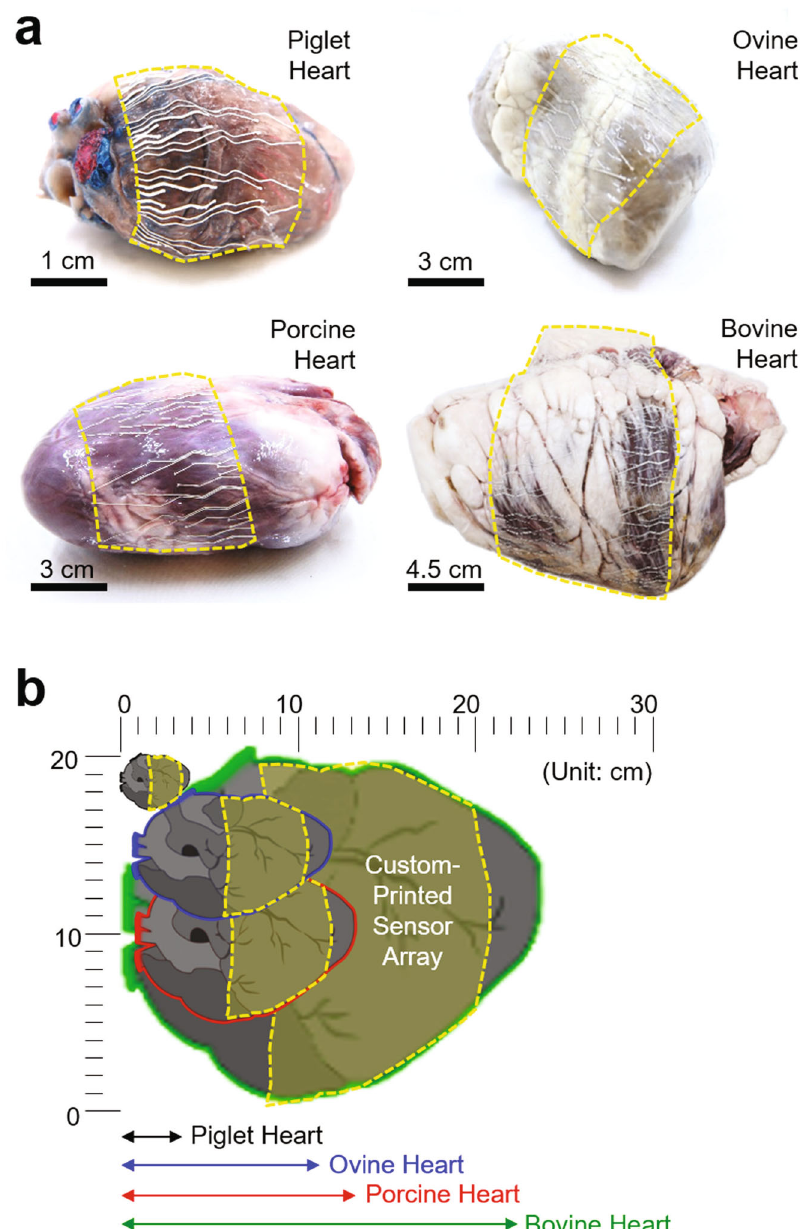
Fig. 3 Rapid custom prototyping. a Photographs of the custom-printed sensor arrays, each of which was customized to fi t with the enucleated piglet, ovine, porcine, and bovine hearts from upper left to bottom right clockwise. b Schematic illustration of the cross-sectional view of the